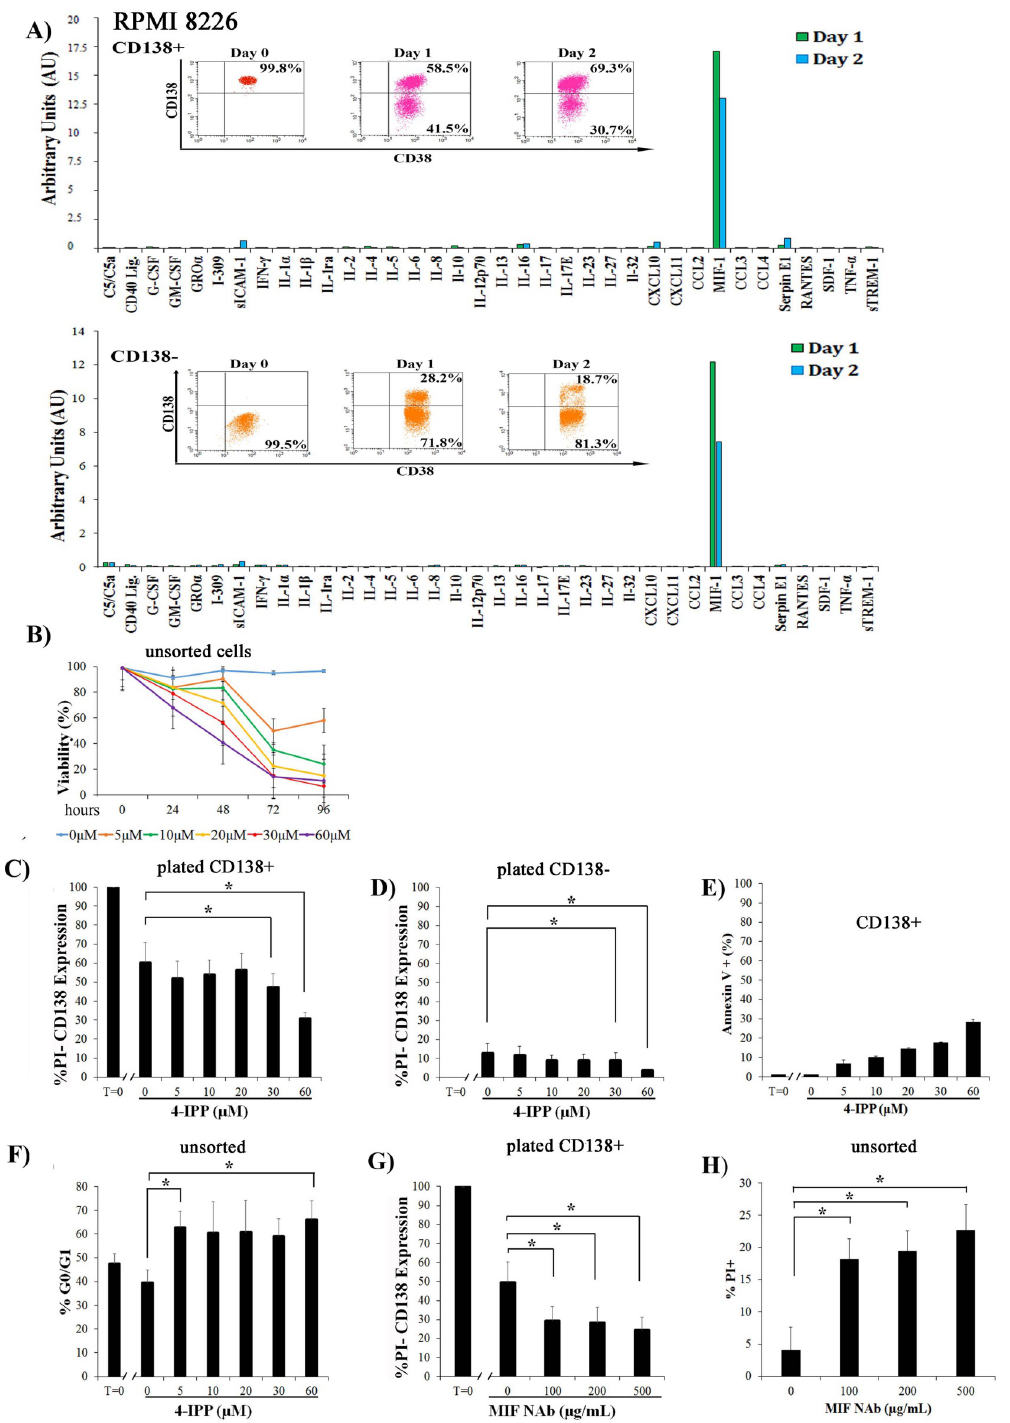
Fig 4. MIF-1 regulates differentiation status of RPMI 8226 cells. A) Sorted CD138+ or CD138- cells were plated and media was harvested at T0, T24 and T48 and used in the cytokine array assay. AU plotted as the expression of 36 different cytokines. Representative of N = 3 (CD138+) and N = 2 of (CD138-). Inset: CD138 and CD38 status at each time point, assessed by flow cytometry, to verify differentiation and dedifferentiation of populations during the timecourse. B) Viability measured by PI staining of cells treated with different concentrations of 4-IPP for different timepoints. (N = 3). C) Sorted populations of CD138+ or D) CD138- cells were plated and then treated with increasing concentrations of 4-IPP for 24 h. Cells were stained